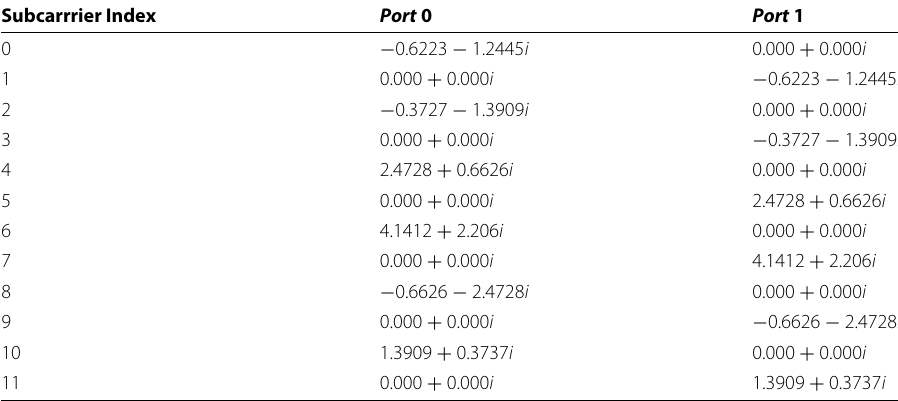
Table 3 DMRS output on port -0, port